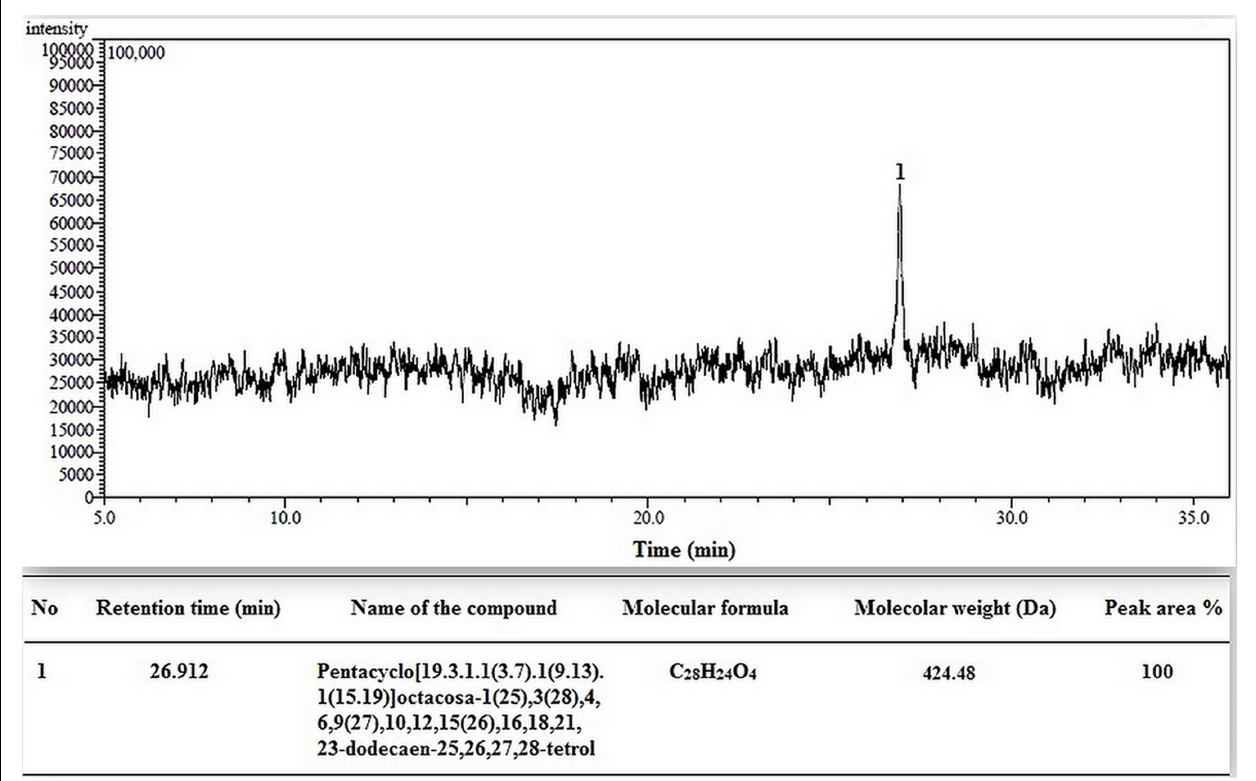
FIGURE 1 | Typical GC-MS chromatogram of Musa balbisiana methanolic root extract. Major compound identified as (1) Pentacyclo[19.3.1.1(3.7).1(9.13). 1(15.19)] octacosa1(25),3(28),4,6,9(27),10,12,15(26),16,18,21,23-dodecaen-25, 26, 27, 28-tetrol.